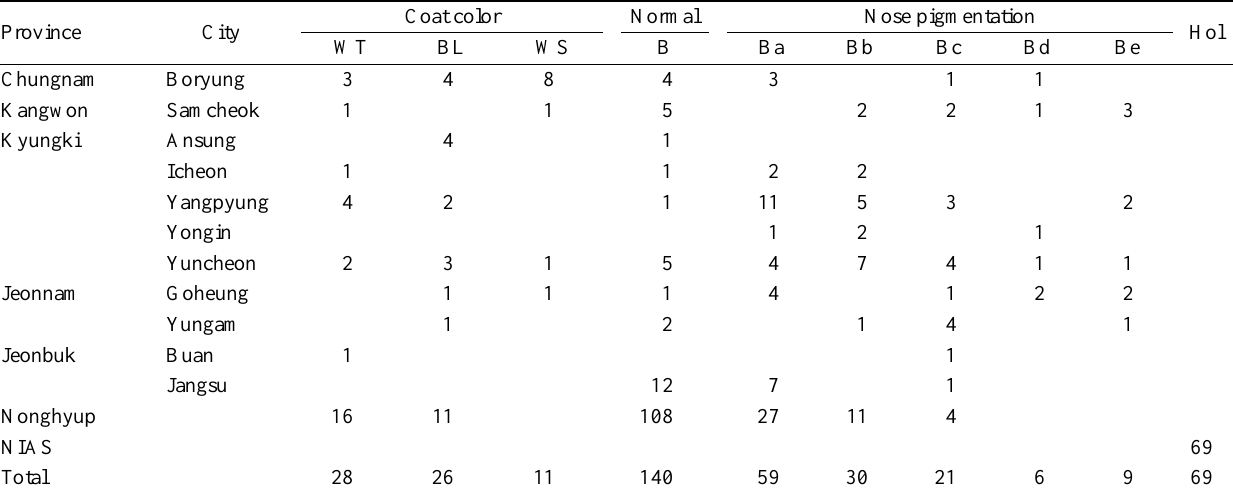
WT = White coat mixed with brown, BL = Black coat mixed with brown, WS = White spotted coat separated with brown, B = Hanwoo cattle with a cuticolor nose and pure brown coat, B (a to e): B (a to e): a-e represent different degree of nose pigmentation with “a” being the lightest and “e” the darkest, Hol = Holstein animals utilized as dairy cattle in Korea, NIAS = National Institute of Animal Science in